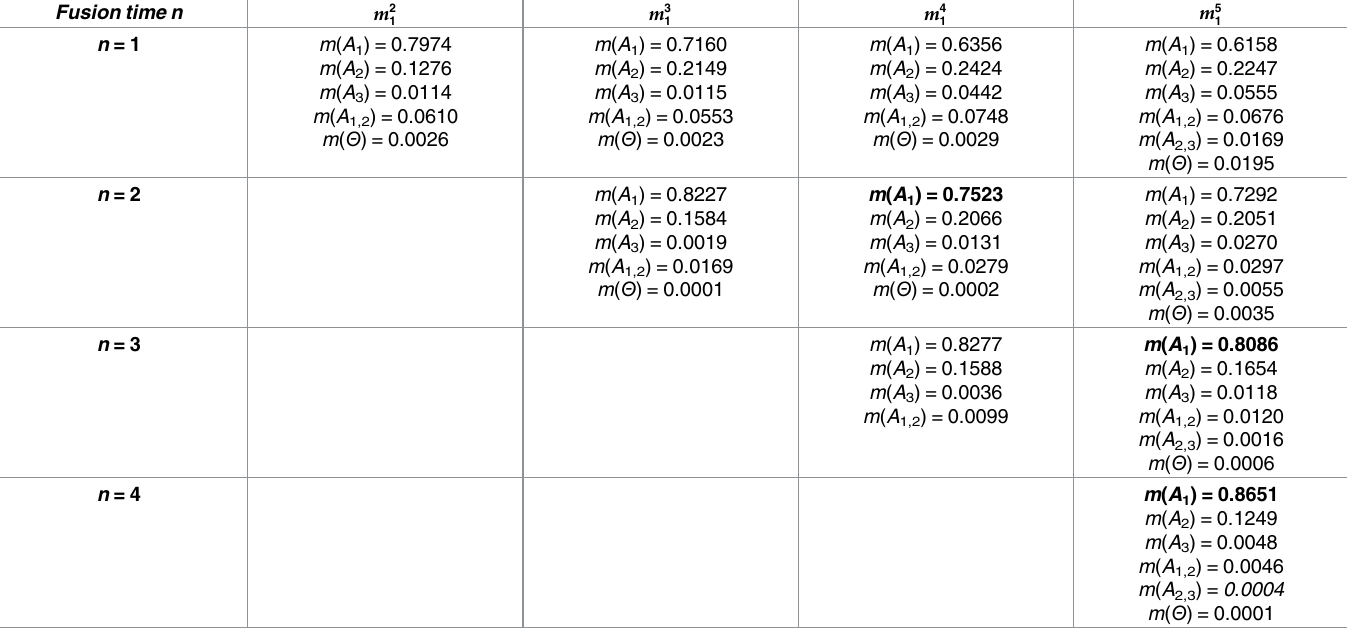
Table 3. The convergence of the proposed